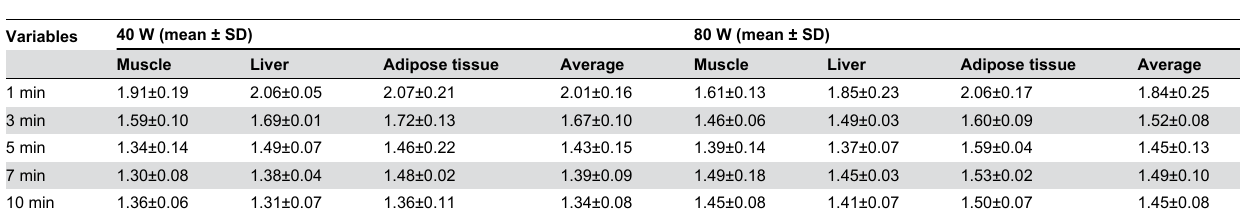
Table 2. Ellipticity index of microwave ablation zones.